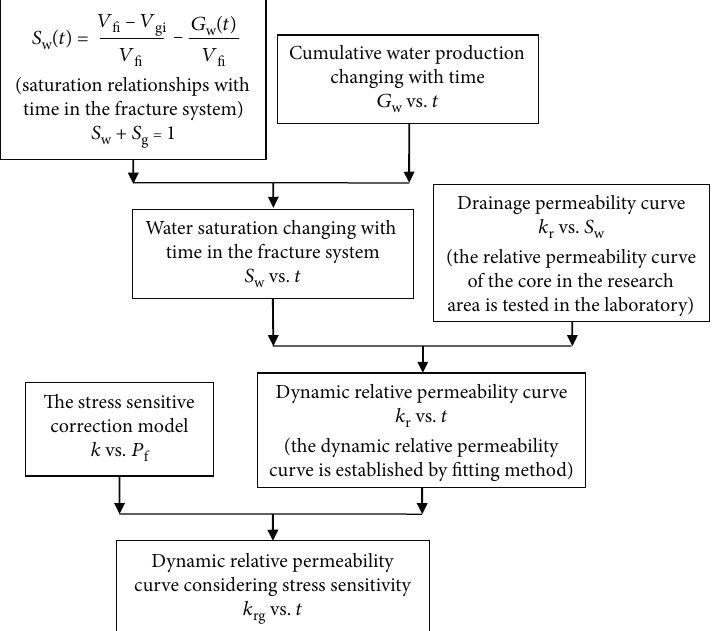
Figure 5: Procedure to estimate the dynamic relative permeability (DRP) curve considering stress